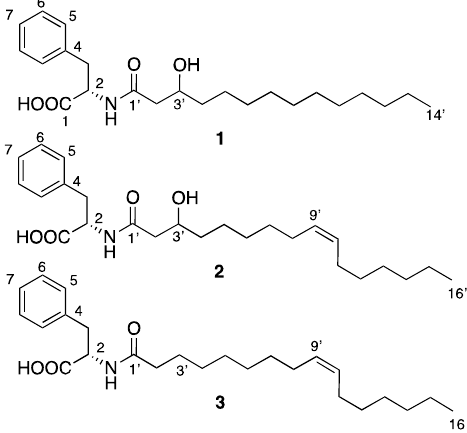
Figure 1. Compounds (1 – 3) isolated from Pantoea sp.